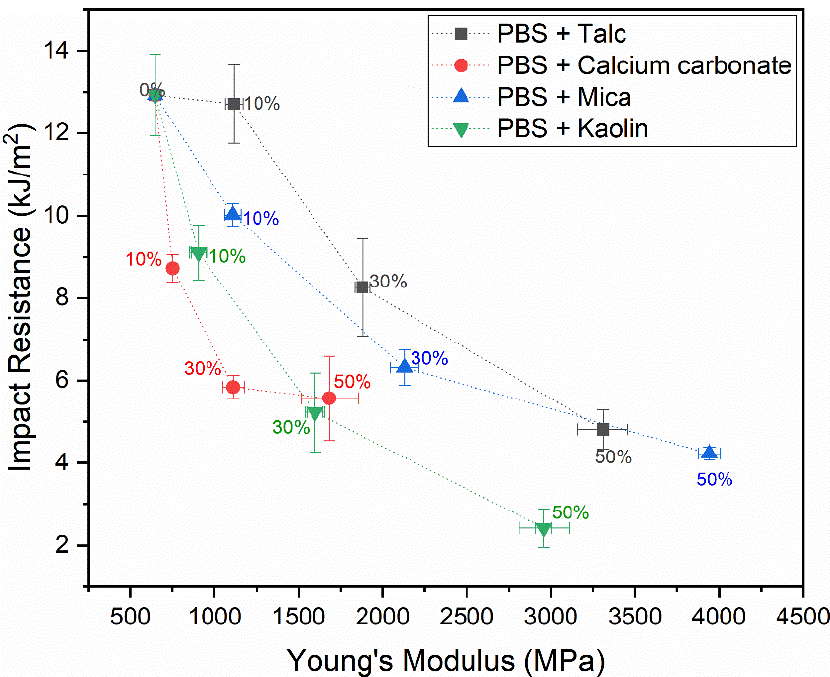
Figure 2. Relation between the Young’s modulus and notched impact resistance particulate PBS composites.